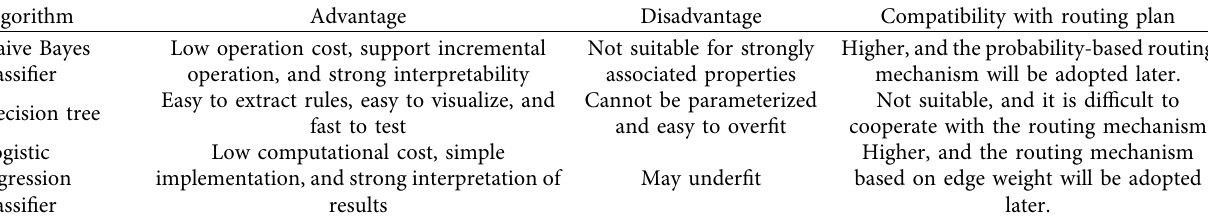
Table 5: Comparative analysis of the characteristics of three classification